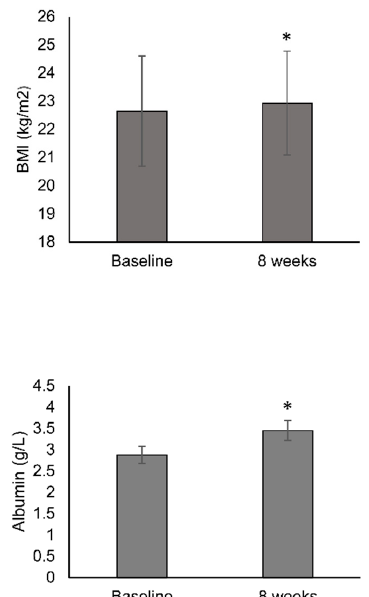
Figure 2. Change in body mass index and albumin levels after 8 weeks of oligomeric enteral nutrition (OEN). The bars show mean ± SD levels for body mass index (BMI) and albumin at baseline and after 8 weeks of OEN treatment. * indicates p < 0.05 (from baseline to week 8).